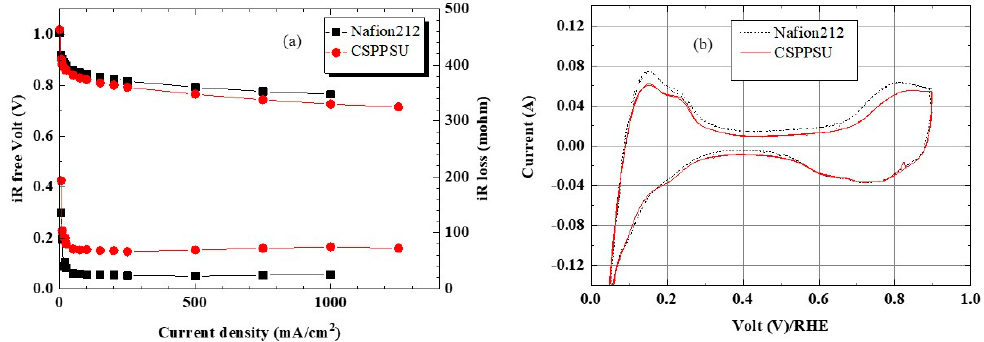
Figure 7. ( a ) I-V iR free and ( b ) CV properties of CSPPSU and Nafion212 membranes at 80 °C and 100% RH.